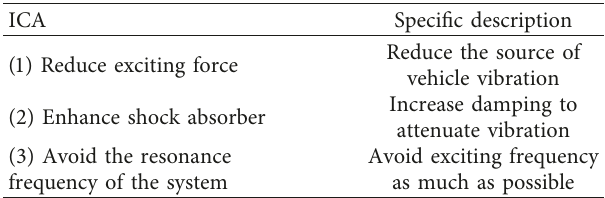
Table 4: Criteria for selecting emergency response